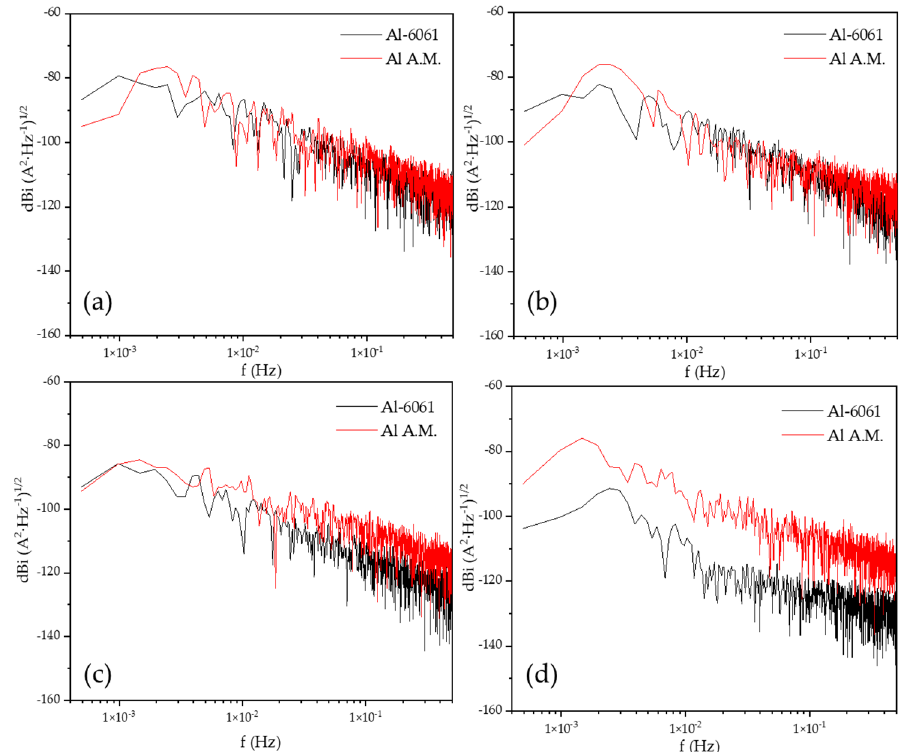
Figure 9. Power spectral density (PSD) in current in NaCl solution, ( a ) 0 h, ( b ) 24 h, ( c ) 48 h, and ( d ) 120 h.